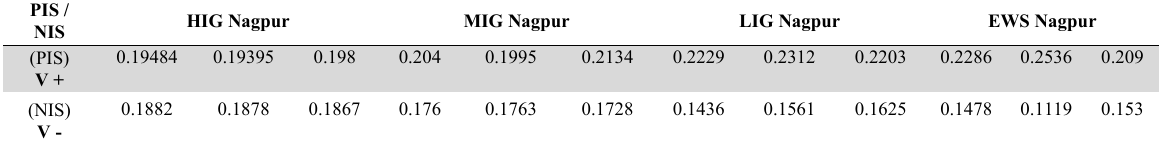
Values for Positive and Negative ideal solution of Nagpur Board PIS / NIS